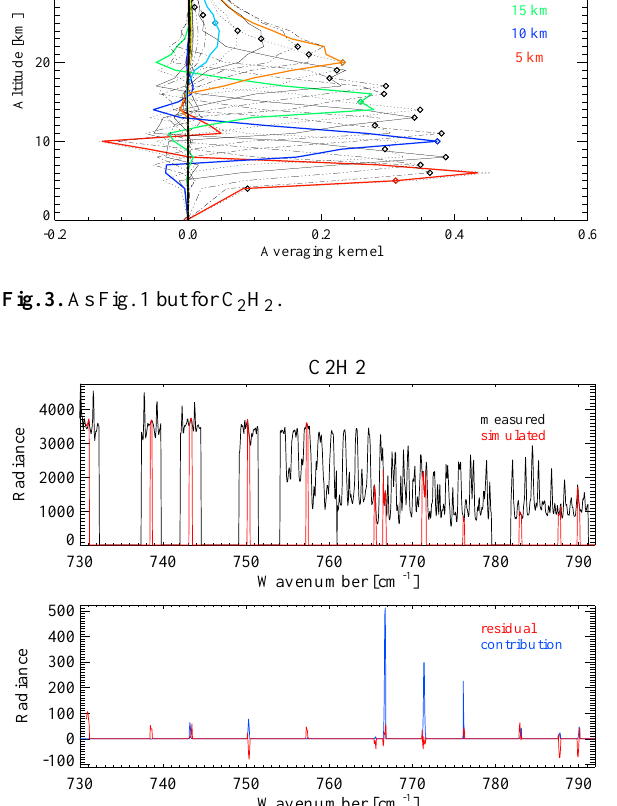
Fig. 4. As Fig. 2 but for C 2 H 2 . The RMS difference for the shown set of microwindows is 46.22nW/(cm 2 srcm − 1 ) .